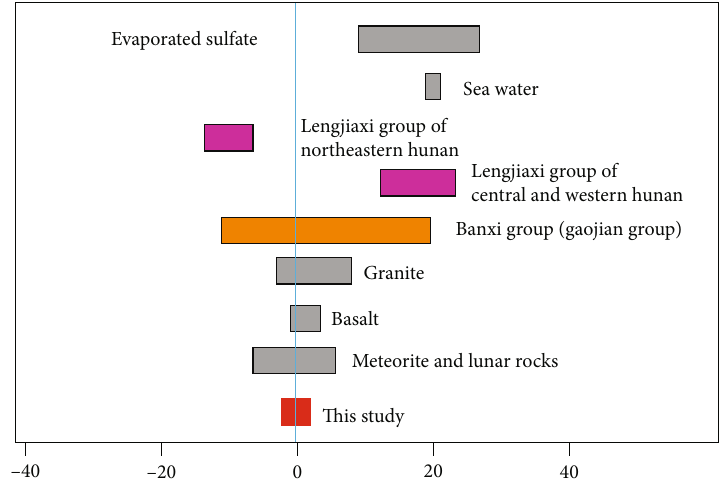
Figure 12: Sulfur isotope composition of ores in Daping gold deposit (modi fi ed after [46, 65 – 67]). Data of the Lengjiaxi Group and Banxi Group (Gaojian Group) are from Luo [68] and Liu et al.